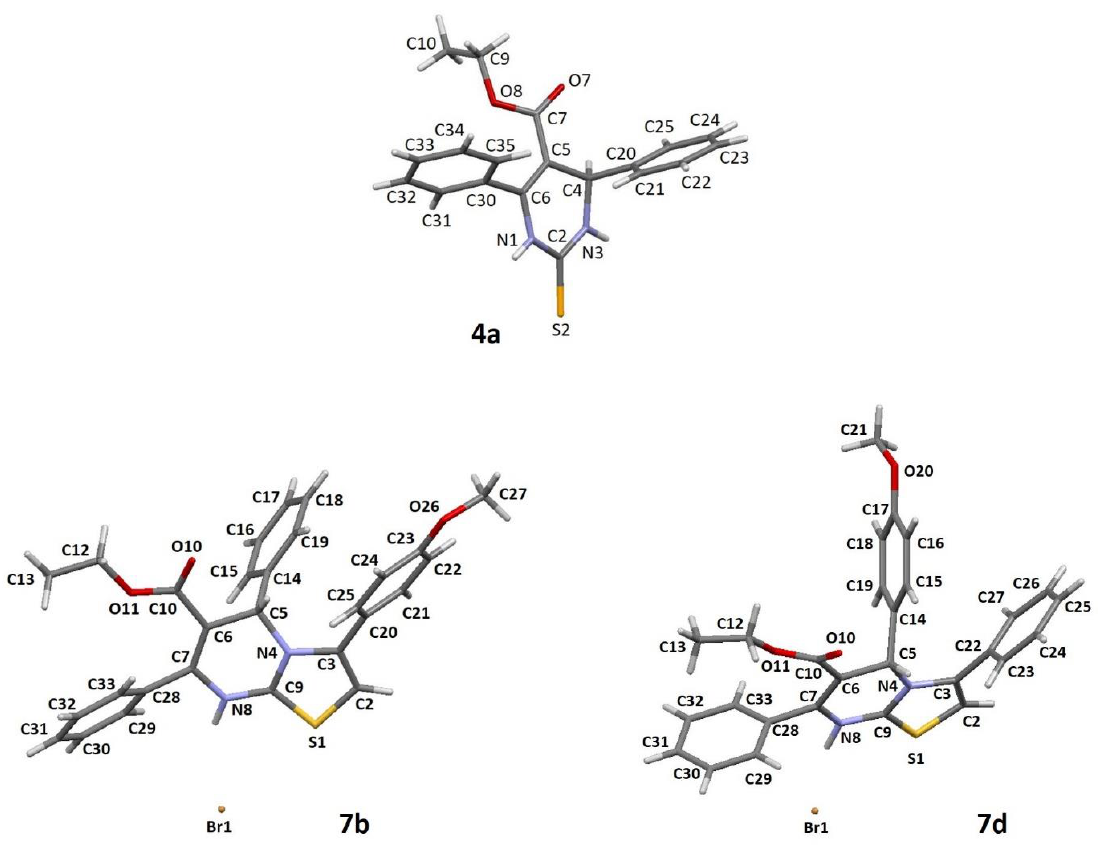
Figure 2. Diagrams of the molecular structures of compounds 4a , 7b , and 7d showing the atomic labelling scheme.